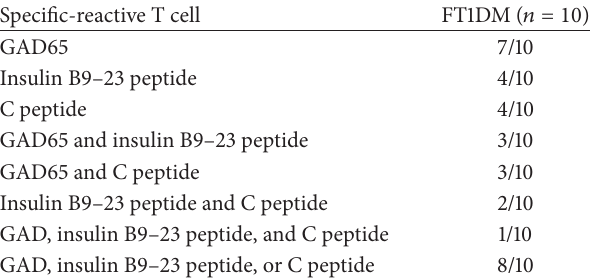
Table 4: Distribution of GAD65 and insulin B9–23 peptide and C peptide reactive T cell in 10 Chinese FT1D